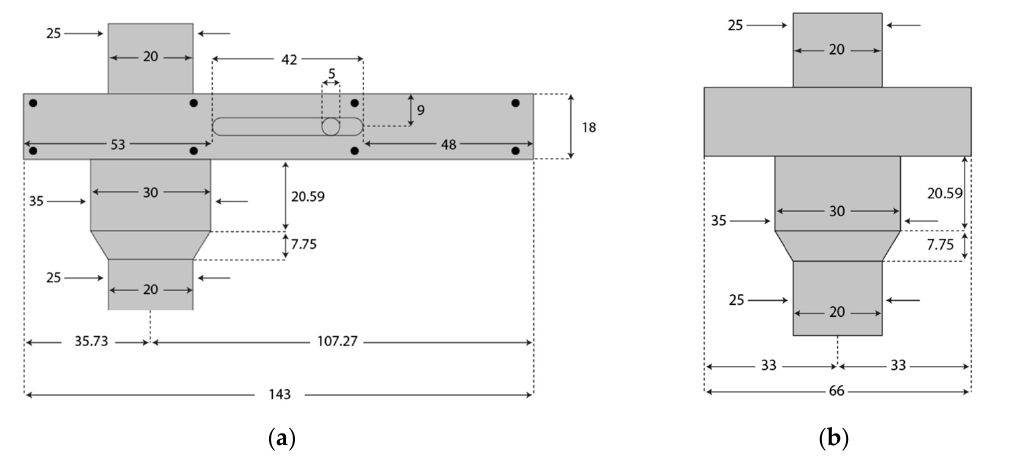
Figure 7. First valve geometry. ( a ) Front view; ( b ) side view.